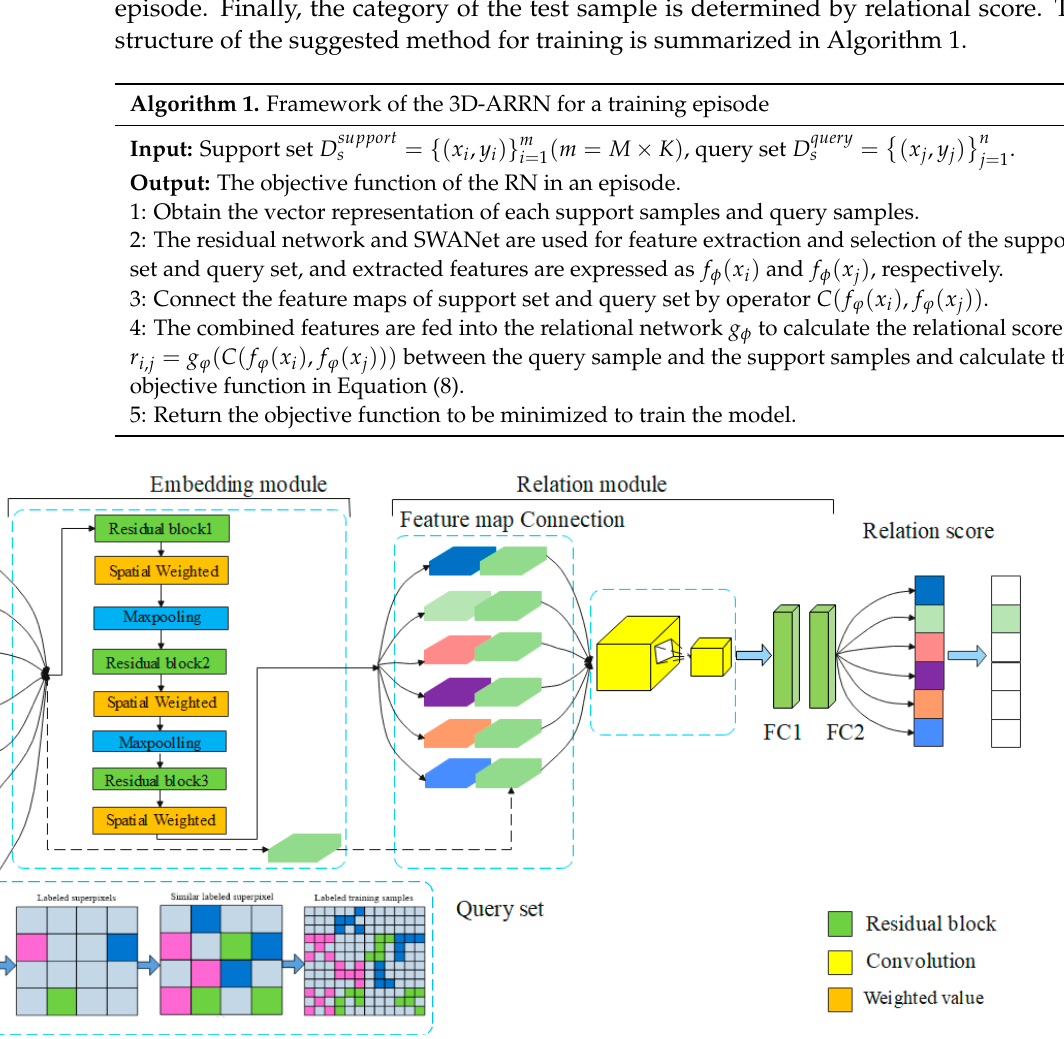
Figure 4. The overall network structure of the 3D-ARRN.